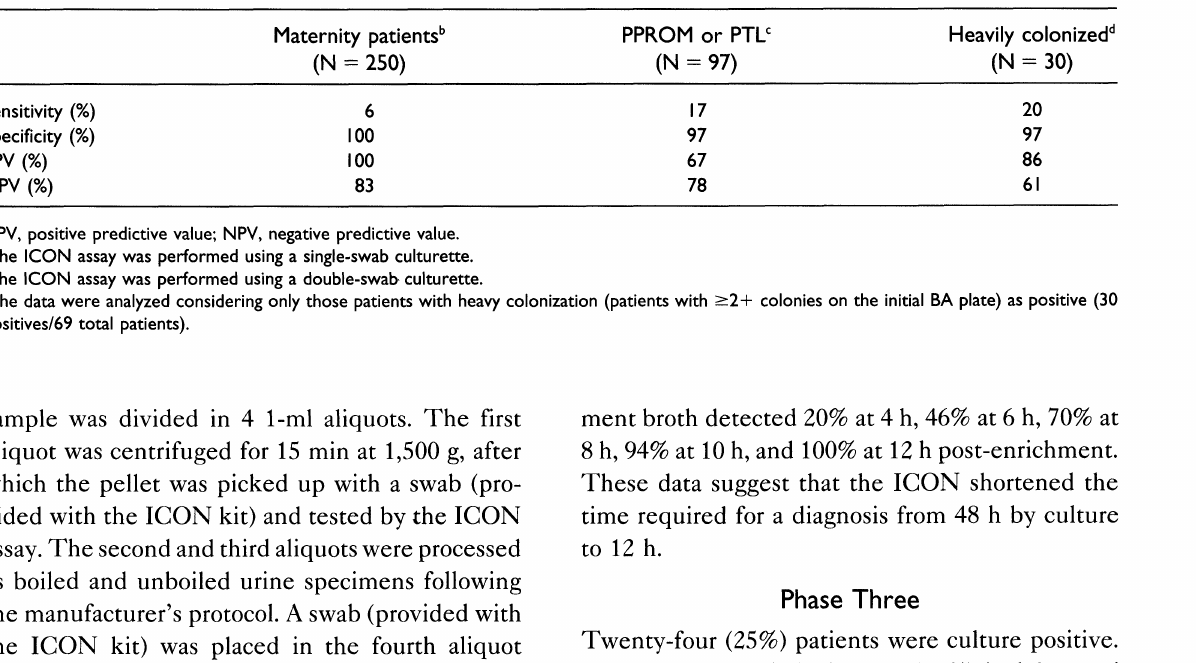
TABLE I. Sensitivity, specificity, and predictive value of direct ICON rapid GBS detection kit in comparison with selective GBS